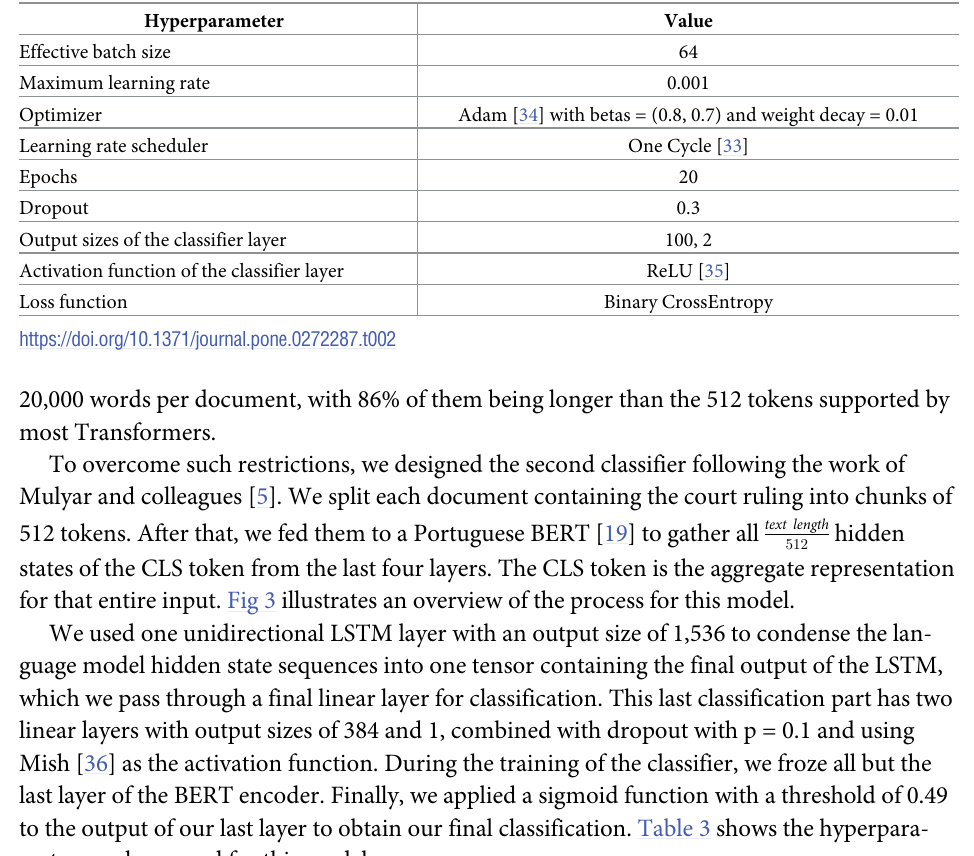
Table 2. Hyperparameters for the ULMFiT classifiers.